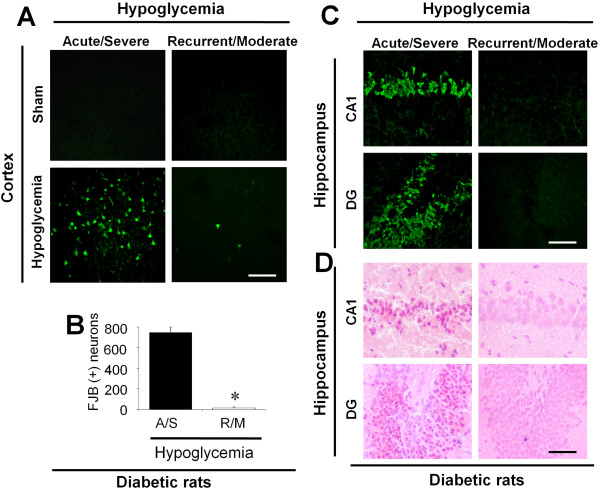
Neuronal death in the cerebral cortex and hippocampus after severe or moderate hypoglycemia in diabetic rats. (A) In sham hypoglycemia-operated rats, neuronal death (FJB (+) neurons) was not detected in diabetic rats. In both diabetic and non-diabetic rats, recurrent/moderate (R/M) hypoglycemia shows only occasional neuronal death in the cerebral cortex while acute/severe (A/S) hypoglycemia shows widespread neuronal death in the superficial layer of cortex at 7 days after hypoglycemia. Bar = 100 μm. (B) Bar graph represents counted degenerating neurons in the cerebral cortex. Data are mean + s.e.m.; n = 5 in R/M hypoglycemia, n = 7 in A/S hypoglycemia * P < 0.05. (C) R/M hypoglycemia shows no neuronal death (FJB (+) neurons) in the hippocampal CA1 and DG cell layer while severe hypoglycemia shows substantial neuron death in the hippocampus at seven days after hypoglycemia. Bar = 100 μm. (D) Light microscopic images represent hematoxylin & eosin (H&E) stained hippocampus from CA1 and DG cell layer. R/M hypoglycemia shows no neuronal death (eosinophilic) in the hippocampal CA1 and DG cell layer while severe hypoglycemia shows substantial neuronal death in the hippocampus at seven days after hypoglycemia. Bar = 100 μm.